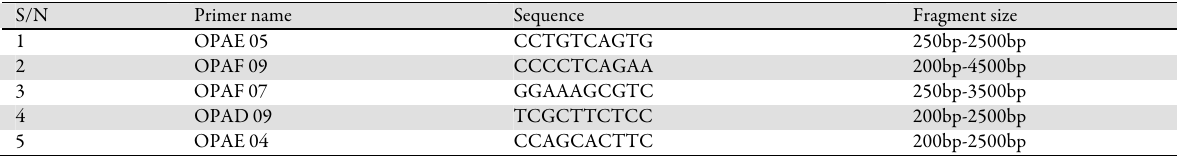
Table 1. List of the used primers and their sequences